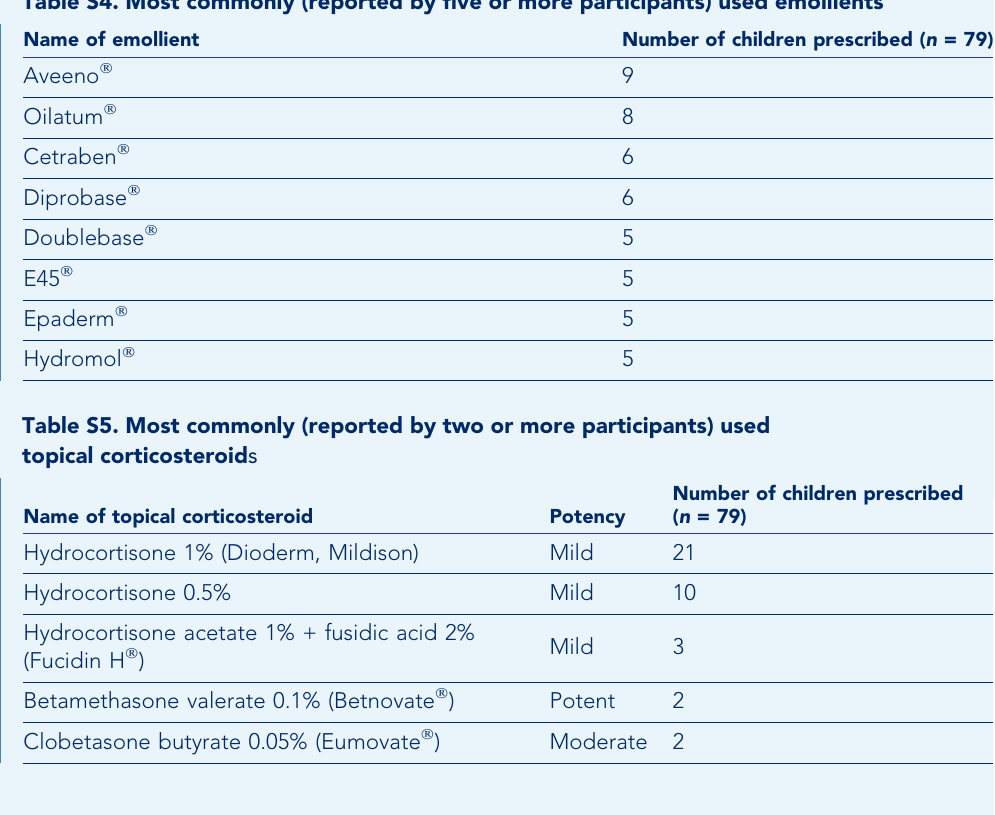
Table S4. Most commonly (reported by five or more participants) used emollients